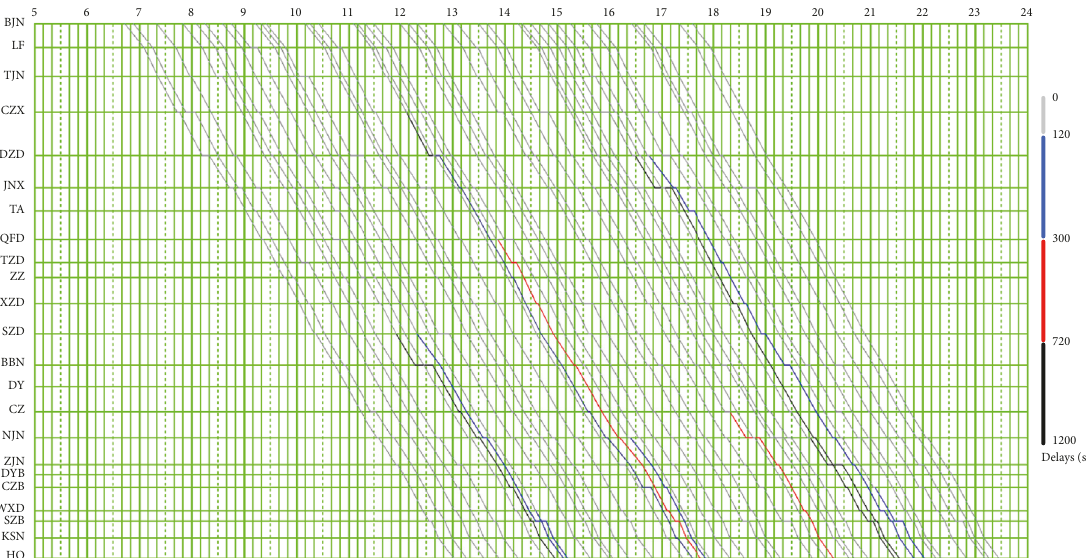
Figure 8: The delays distribution of each train.